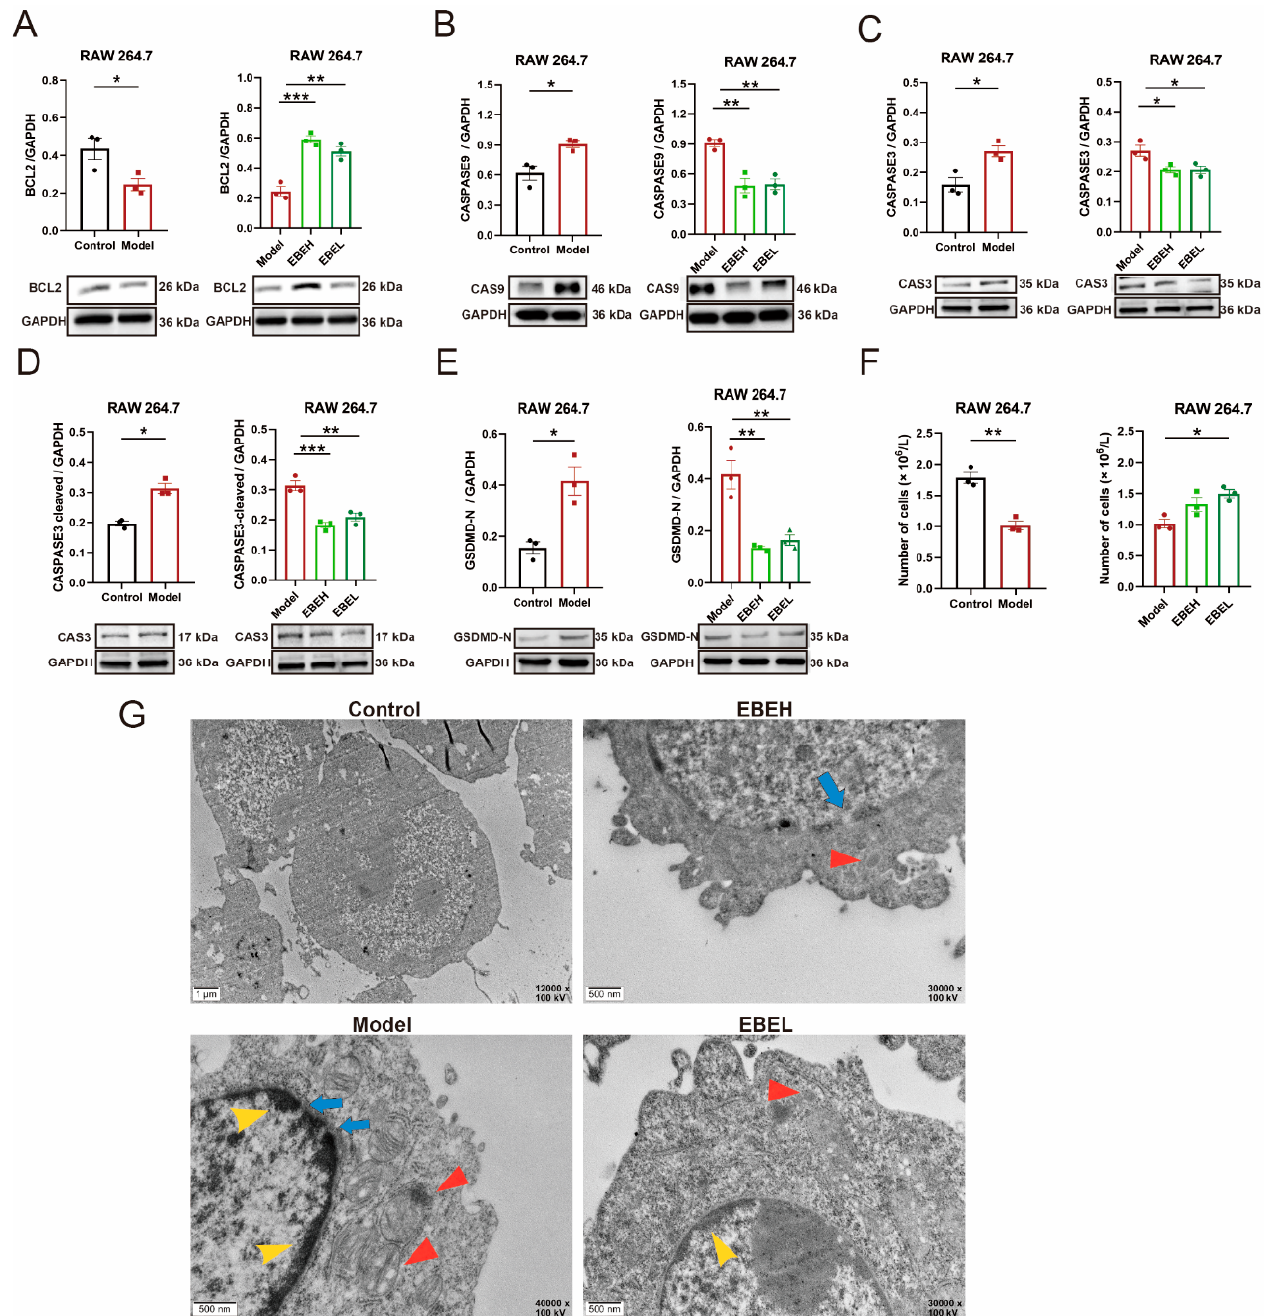
Figure 5. EBE inhibited pyroptosis of cells model by BCL2. ( A – F ) BCL2 ( A ), CASPASE9 ( B ), CASPASE3 ( C ), CASPASE3-cleaved ( D ), GSDMD-N ( E ), and numbers of living cells ( F ) for RAW 264.7 of vehicle treatment (Control), RAW 264.7 of LPS (Model), model of 50µg/mL EBE treatment (EBEH) and model of 12.5µg/mL EBE treatment (EBEL). ( G ) Transmission electron microscopy images of cells for Control, Model, EBEH and EBEL. Red arrows feature mitochondrial morphology, blue arrows feature membrane pores and yellow arrows feature heterochromatin marginalizing. ( A – E ) were measured by western blotting. Unpaired t -test and ordinary one-way ANOVA were used on experimental data. Data are presented as mean ± SEM, n = 3. * p < 0.05, ** p < 0.01, *** p <